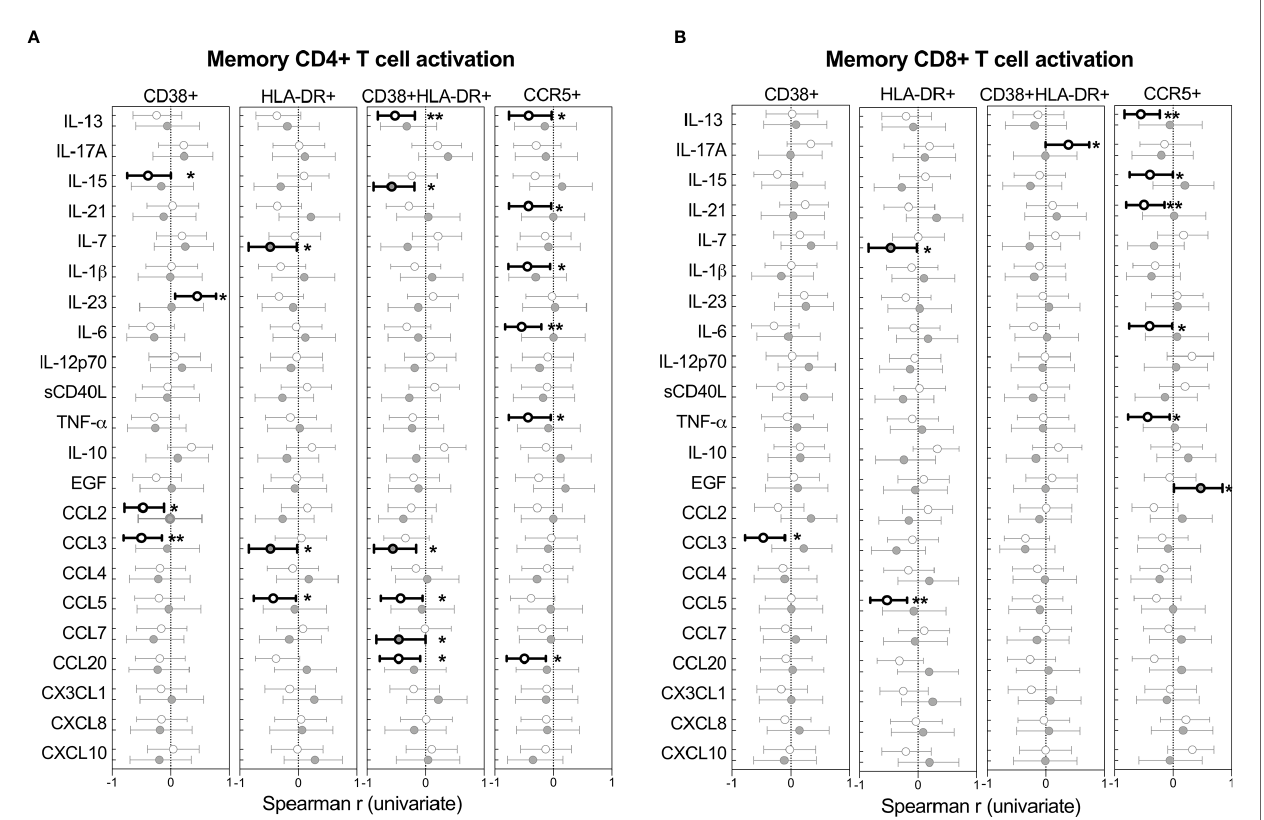
FIGURE 6 | Univariate associations between T cell activation markers and cytokine concentrations in BAL of HIV-infected (n=14) and uninfected (n=21) individuals. Spearman rho (r) of the univariate correlation between each cytokine and the expression of activation markers on (A) CD4+ T cells and (B) CD8+ T cells. Open circles represent HIV-uninfected individuals and fi lled circles represent HIV-infected individuals. Statistically signi fi cant correlations (p<0.05) are indicated in darker lines and symbols. Spearman correlation tests, of which Spearman rho and the 95% con fi dence intervals are reported here. None of the correlations remained statistically signi fi cant after adjusting for multiple comparisons by FDR step down procedures. The p values, p ≤ 0.05, p ≤ 0.01, p ≤ 0.001, p ≤ 0.0001 are reported as *, **, *** and ****,